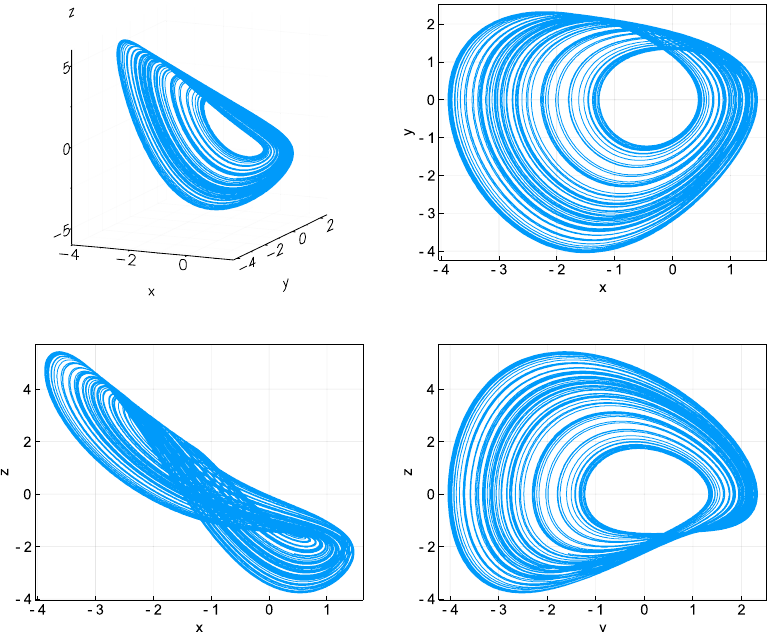
A chaotic attractor of system (23) is shown in Figure 3.